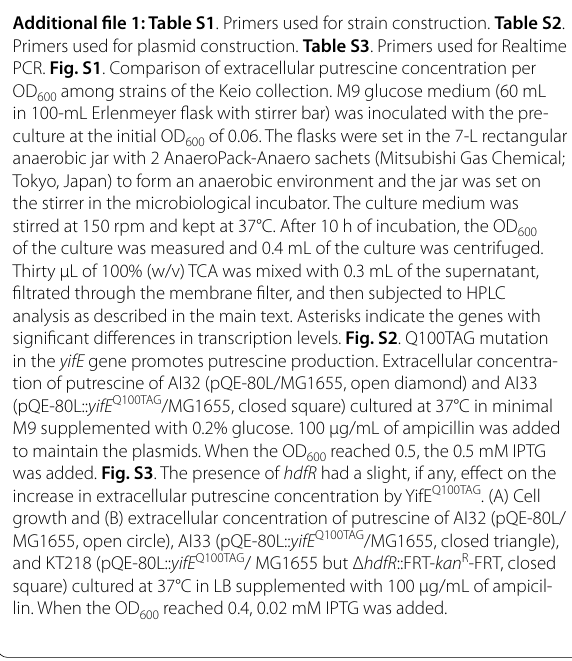
Additional file 1: Table S1 . Primers used for strain construction. Table S2 . Primers used for plasmid construction. Table S3 . Primers used for Realtime PCR. Fig. S1 . Comparison of extracellular putrescine concentration per